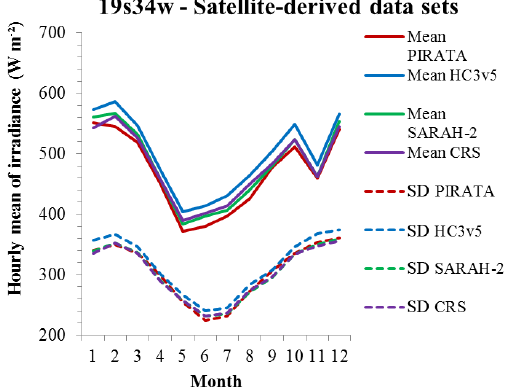
Figure D3. Monthly means (solid lines) and standard deviations (dotted lines) of hourly DSIS, in Wm − 2 , from PIRATA measurements (red) and data sets (HC3v5: blue, SARAH-2: green, CRS: purple) at 19 ◦ S, 34 ◦ W. A difference between red line (measurements) and coloured line (data set) for a given month denotes a systematic error for this month: underestimation if the coloured line is below the red line, overestimation otherwise. For a given month, a coloured dotted line above the red one means that the data set produces too much variability for this month; in the opposite case, the data set does not contain enough